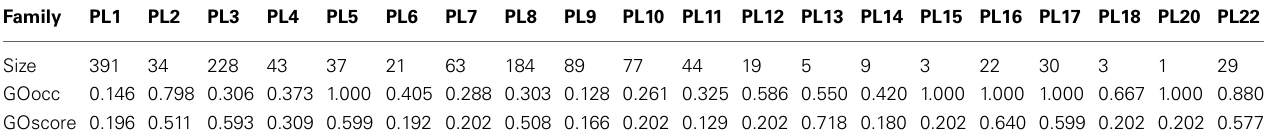
Table 1 | GO annotation scores (GOscore and GOoccurrence) and respective size in number of annotated proteins for each CAZy family in the PL enzyme